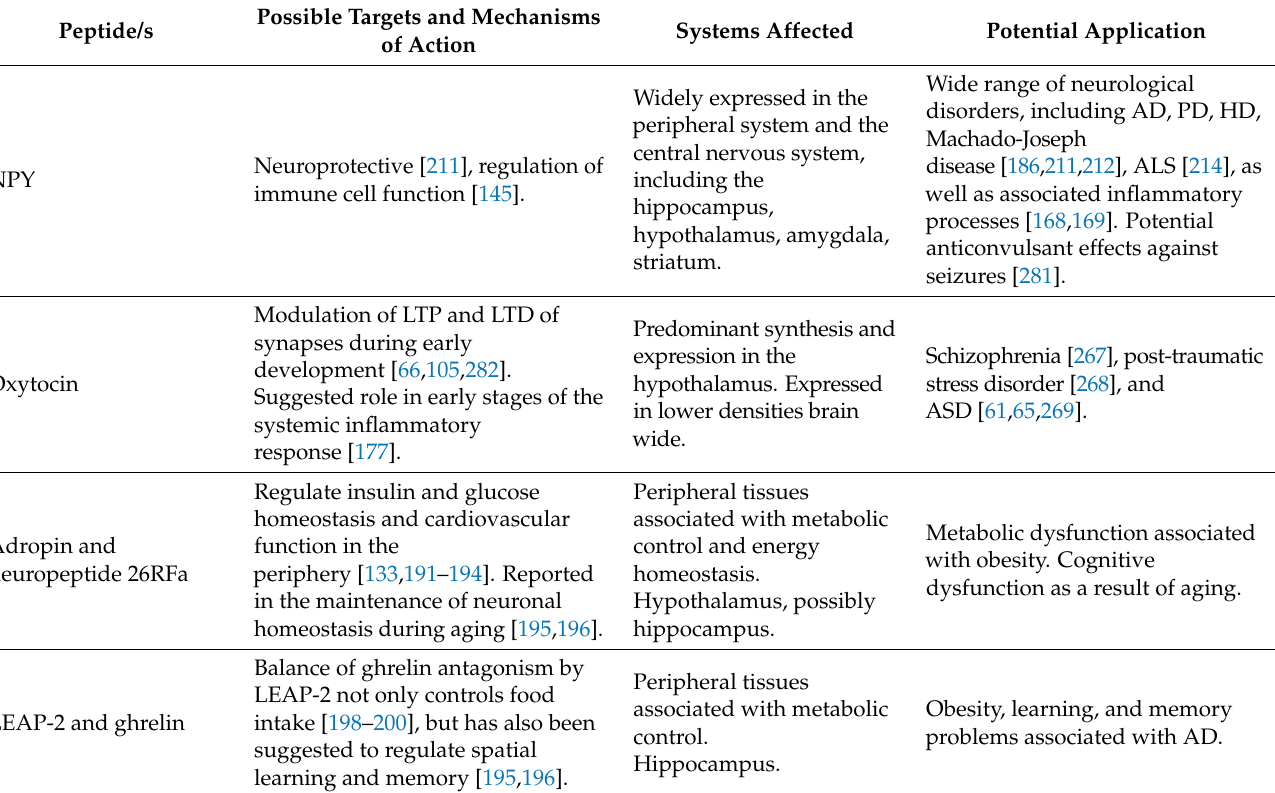
Table 2. Potential neuropeptides and proteinaceous molecules that can be used in